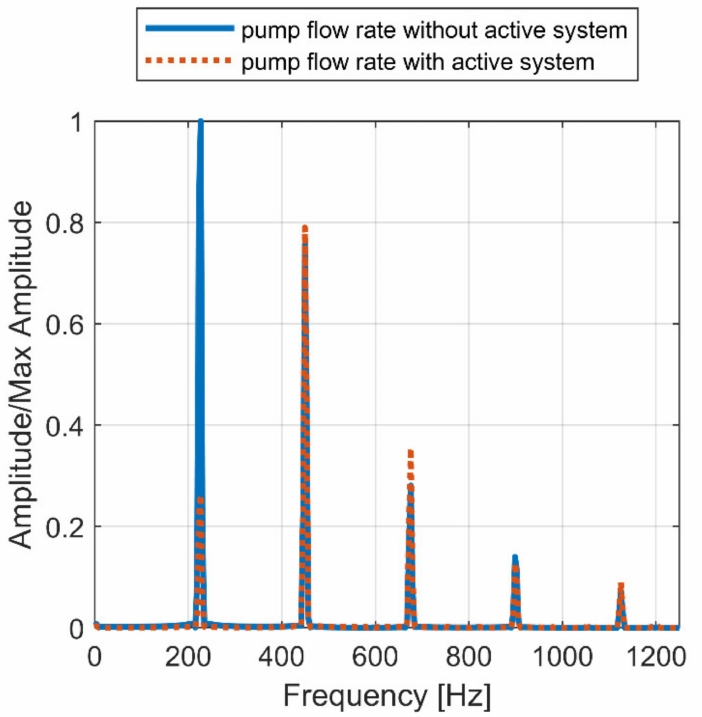
Figure 16. Simulation cycle 2, section 3: flow ripple FFT at 220 bar, 1500 rpm, 50% swash plate